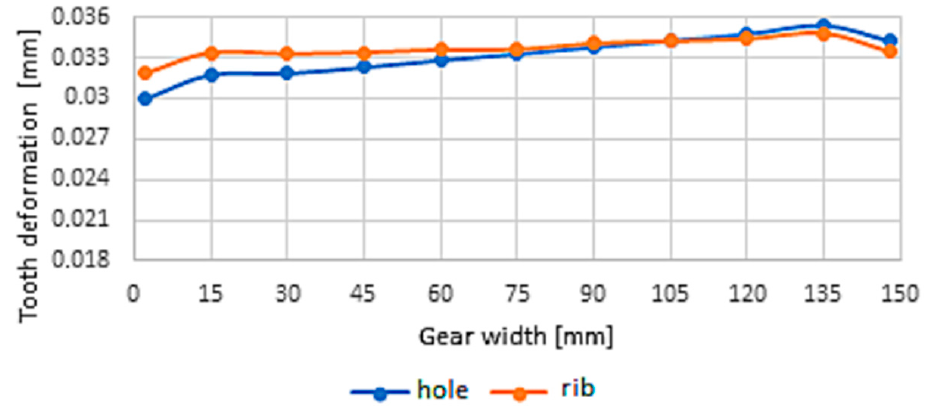
Figure 13. Deformation along the width of the tooth for model B3.